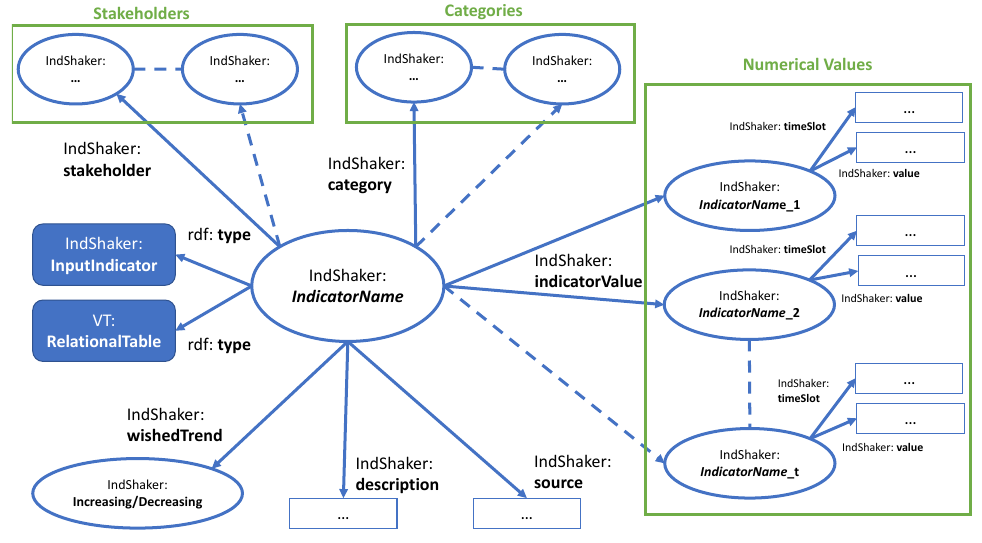
Figure 9. Specification of an input indicator.